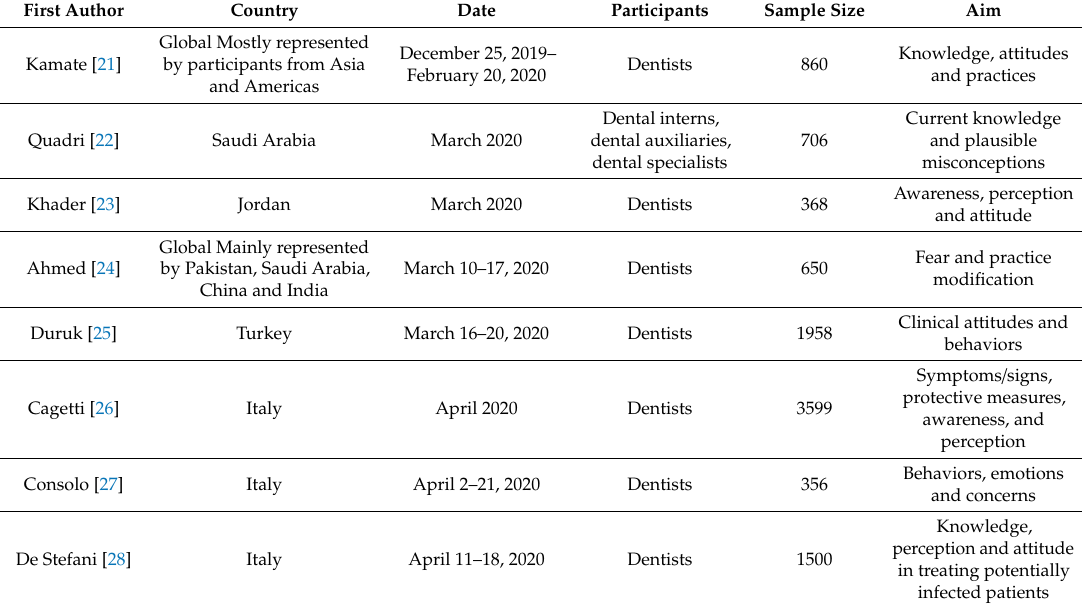
Table 5. The summary of the published questionnaire studies investigating COVID-19 outbreak and dentistry. The studies are presented in chronological order of study date; data searched was finished 4 July